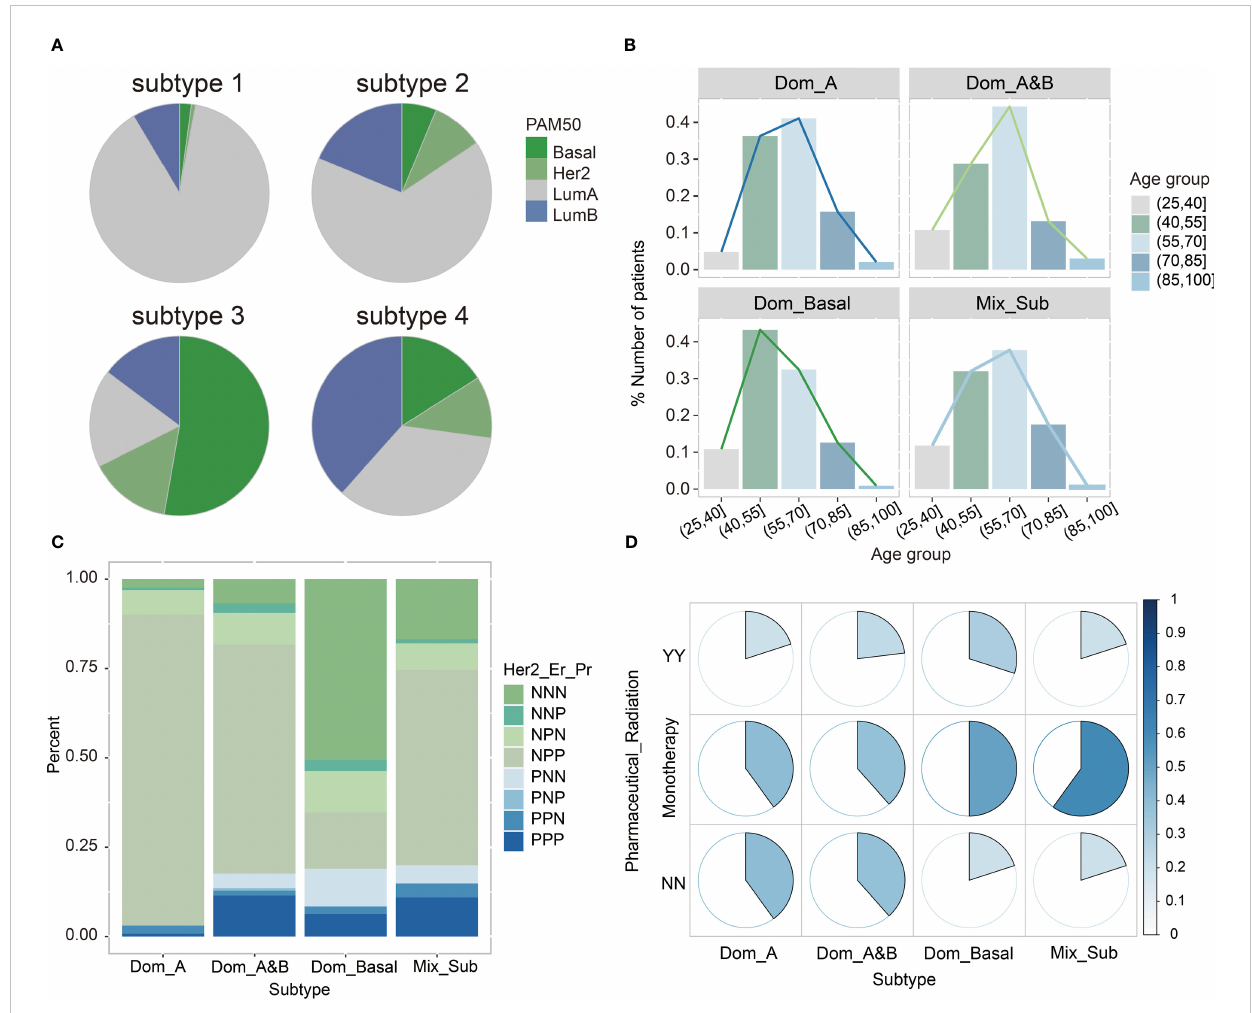
FIGURE 2 (A) The proportion of the existing PAM50 subtypes among the four breast cancer subtypes. (B) The distribution of the four breast cancer subtypes in different age ranges. (C) The status of Her2, Er, Pr in patients with four breast cancer subtypes. N means negative; P means positive. (D) The status of patients with four breast cancer subtypes received pharmaceutical or radiation therapy. YY means receiving two treatments; NN means not receiving any treatments; Monotherapy means receiving either of these two